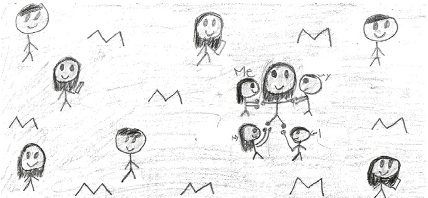
Figure 4: Photo journal drawing representing stage 3: developing a helpful presence.